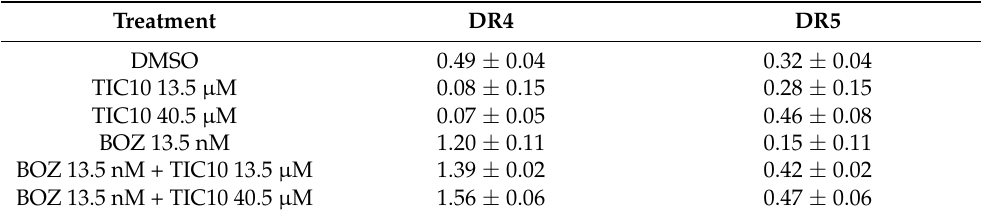
Table 2. Relative death receptor mRNA expression levels after 72 h treatment with bortezomib (BOZ) or TIC10 and their combinations. The data were normalized to the medium control.